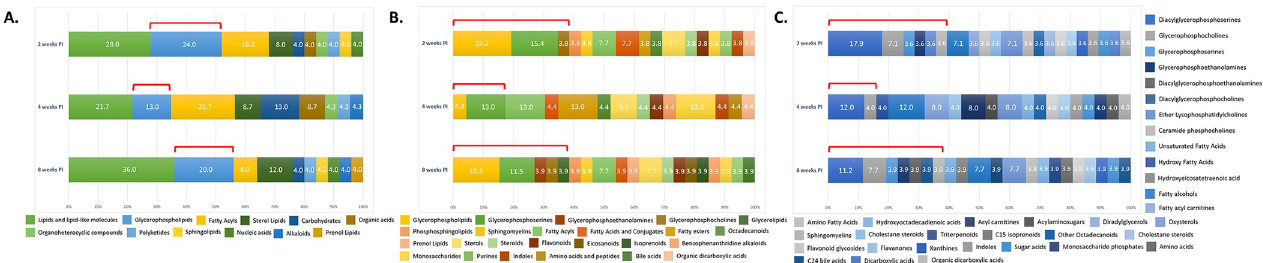
Fig 3. Enrichment of metabolite classes from serum of T . spiralis -infected mice at different timepoints. (A) Enrichment by super-class chemical structure. (B) Enrichment by main-class chemical structure. (C) Enrichment by sub-class chemical structure. Red brackets indicated glycerophospholipid species.